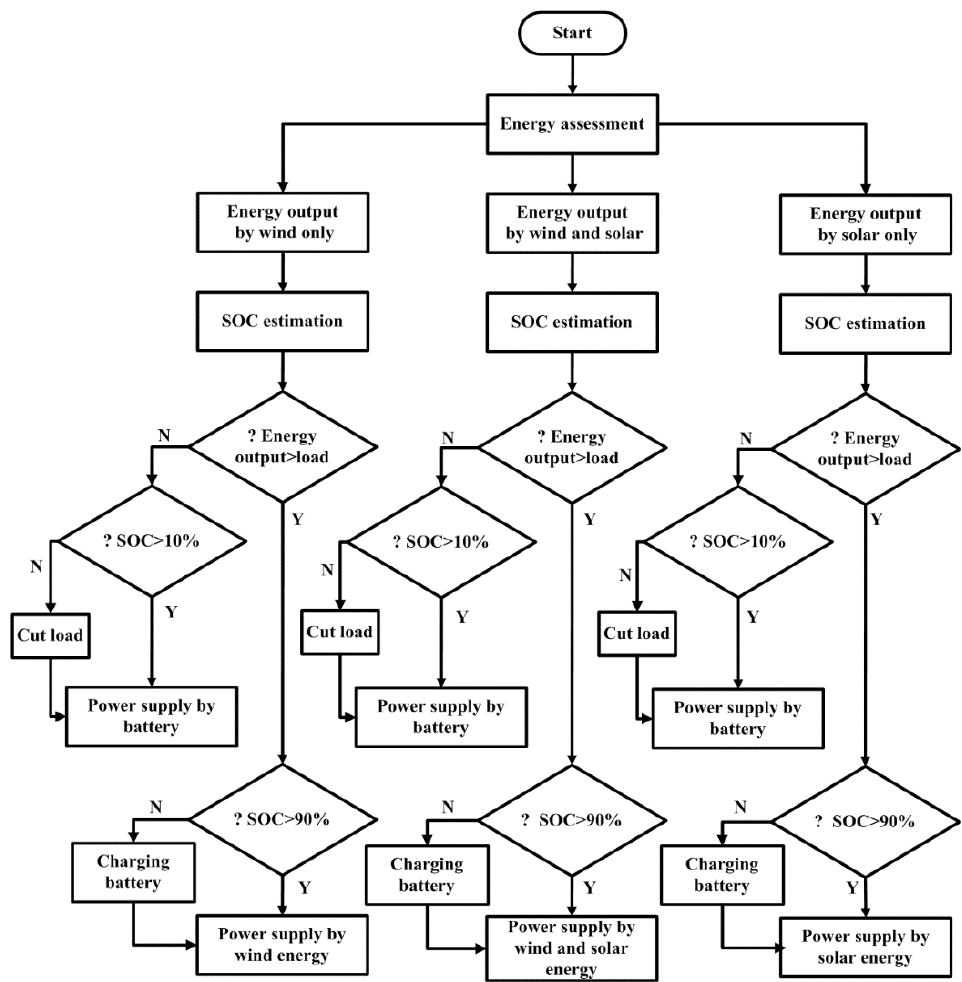
Figure 11. The flowchart of the power supply strategy.